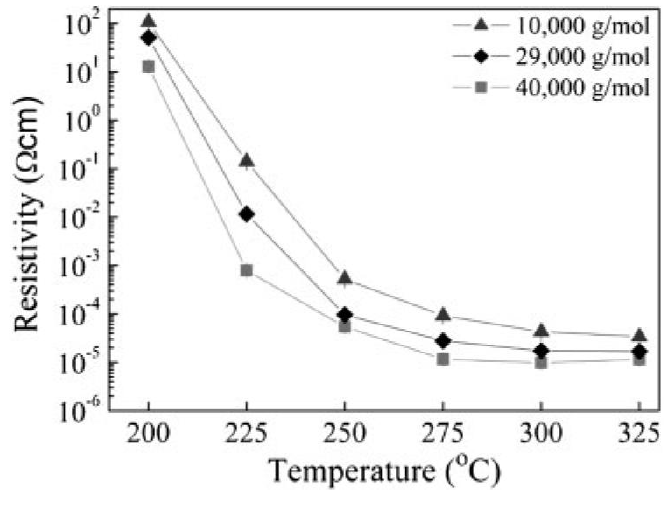
NPs; ( c ) Cu/SiO NPs one 2 2 O. Reprinted from reference [44] with 2